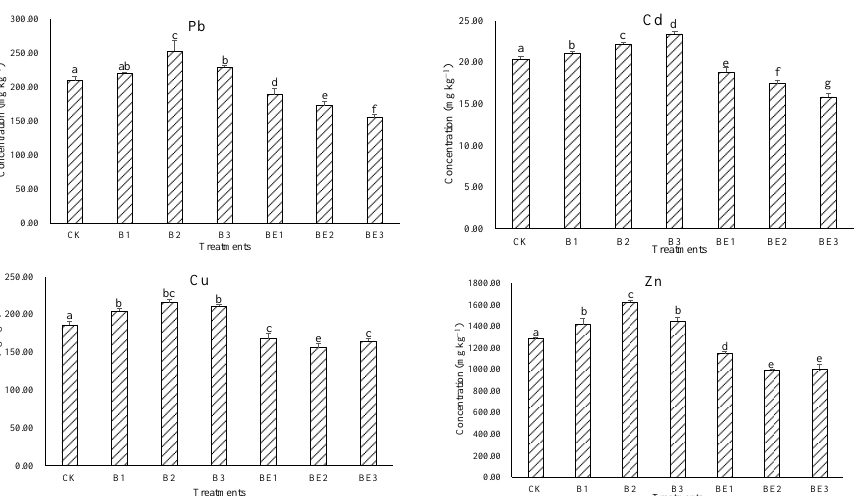
Figure 3. Total heavy metal concentrations in the sludge for different treatments. Data are presented as the mean ± SD for three duplicates. Columns with different letters show a significant difference at p < 0.05 level.